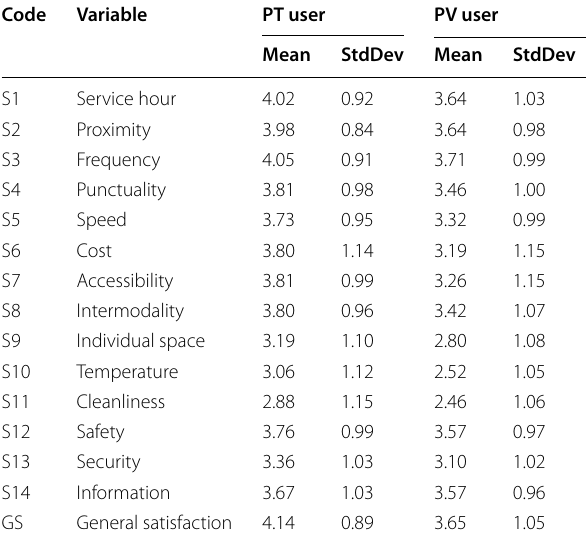
Table 2 The descriptive statistics of the indicators by the two types of users Code